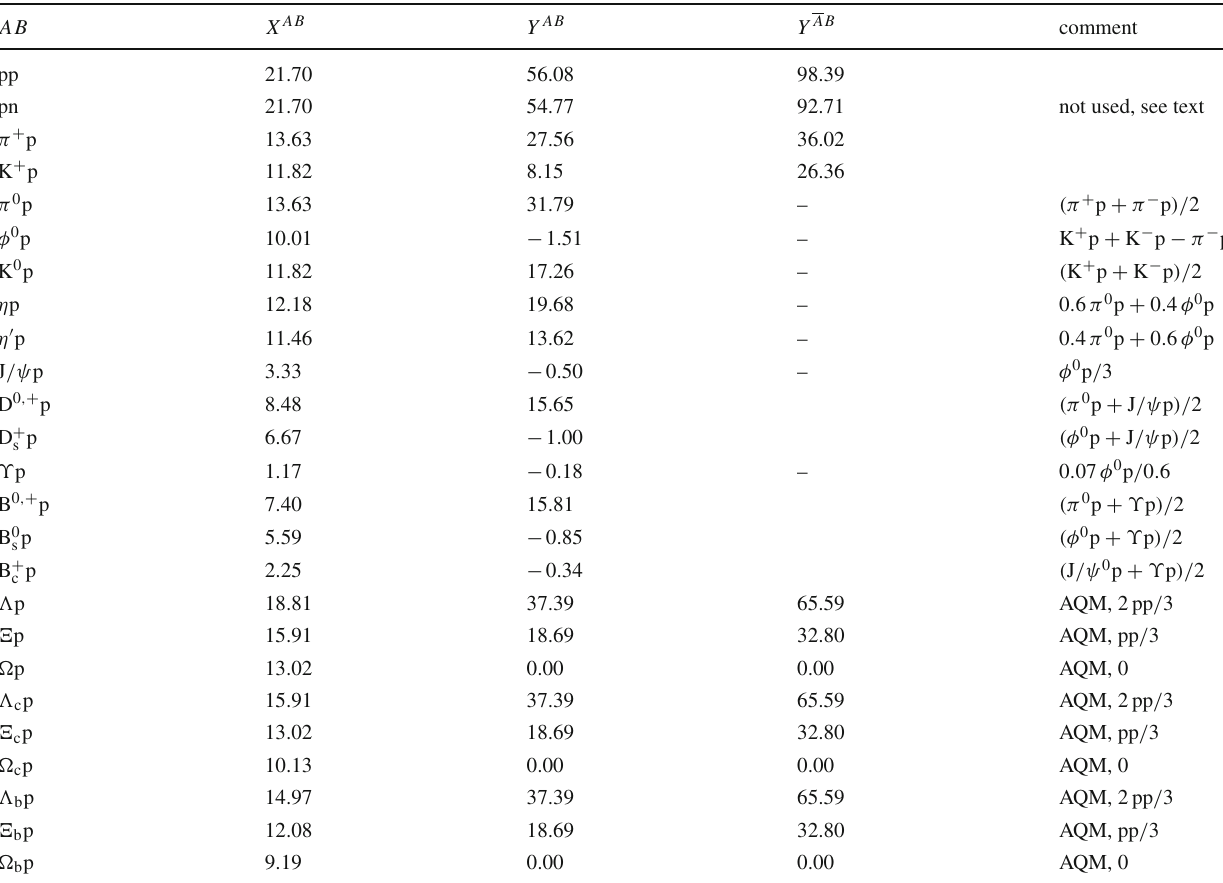
Table 1 Coefficients X AB and Y AB , in units of mb, in Eq. (2) for various beam combinations. First section is from DL [52], second from SaS [56] and the rest are new for this study AB X AB Y AB Y